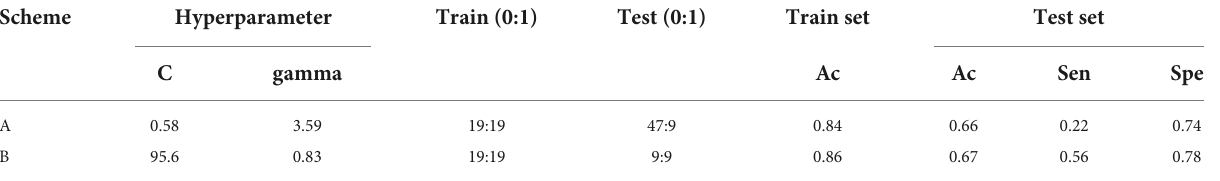
TABLE 3 The results and parameters of machine learning model.